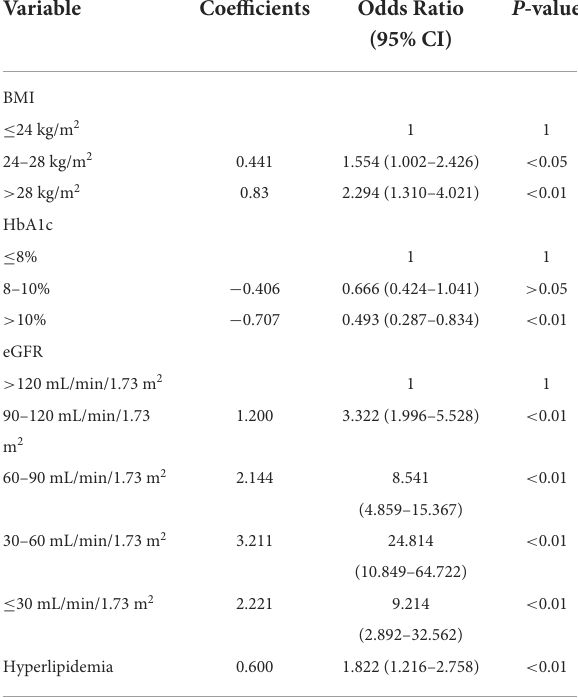
TABLE 2 Multivariate logistic regression